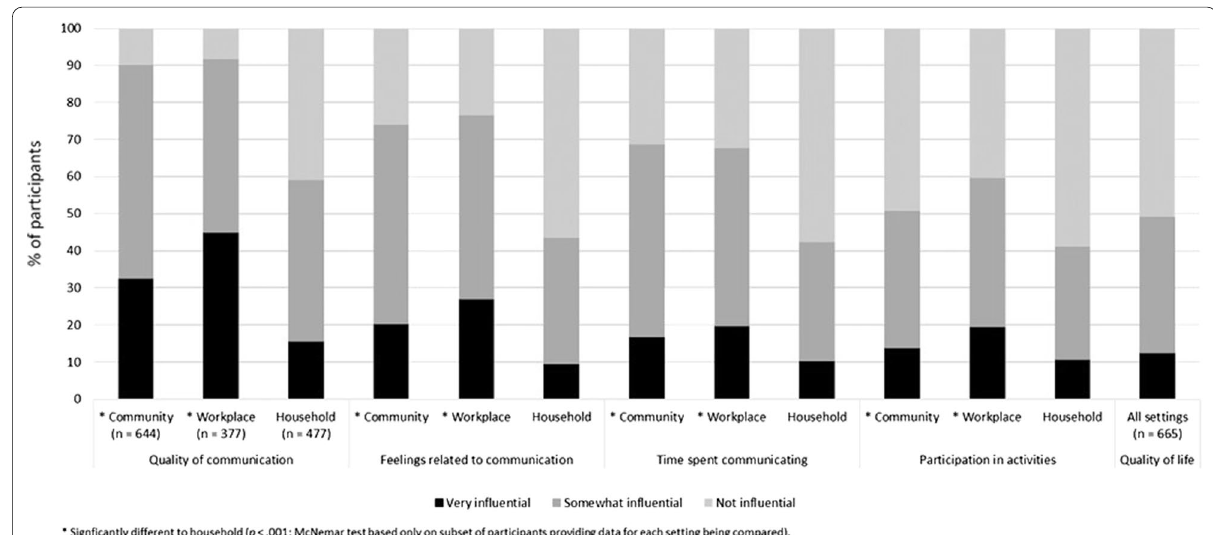
Fig. 1 Percentage of participants who reported face mask use by other people was very, somewhat, or not influential on different aspects of communication and participation in activities when communicating in the community ( n members ( n 477), and on quality of life in general ( n =